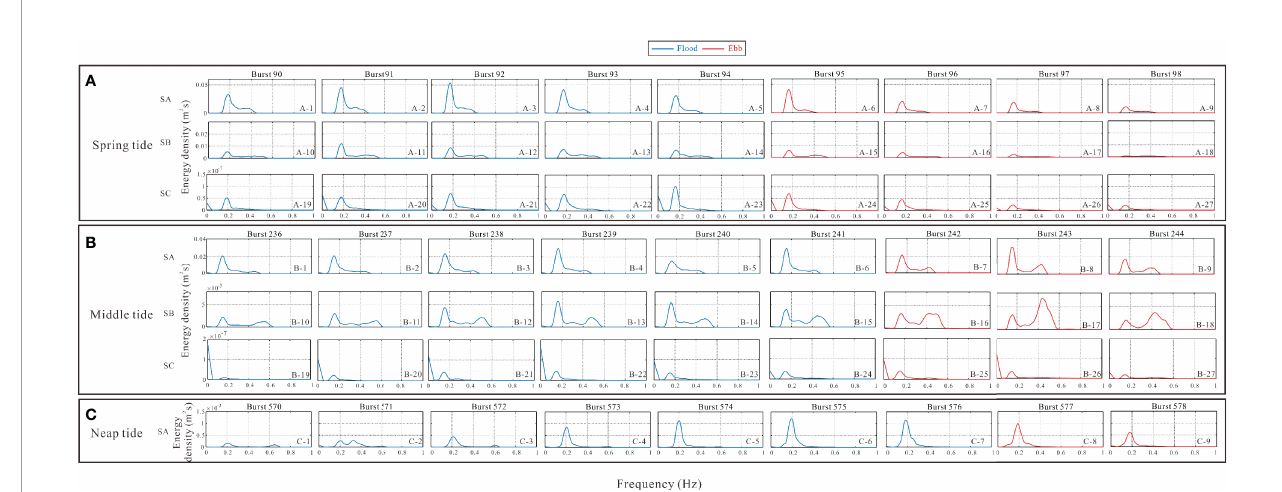
FIGURE 5 | Energy density of the three observation tripods depicted from spring (box A ), middle (box B ) and neap (box C )